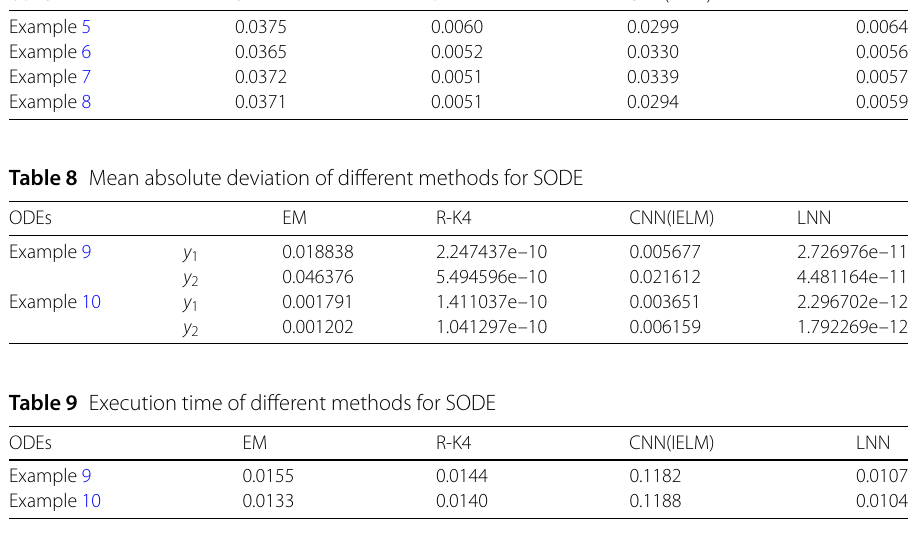
Table 7 Execution time of different methods for second-order ODEs ODEs SM DM Example 5